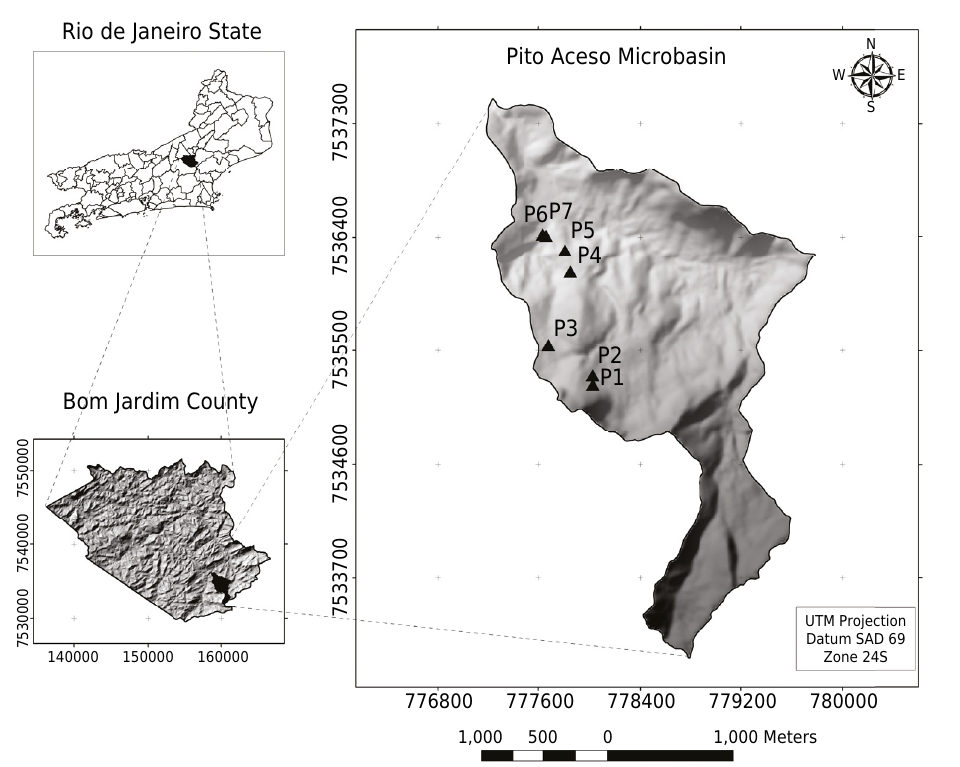
Figure 1. Location of the area studied in the Pito Aceso microbasin, Municipality of Bom Jardim, State of Rio de Janeiro